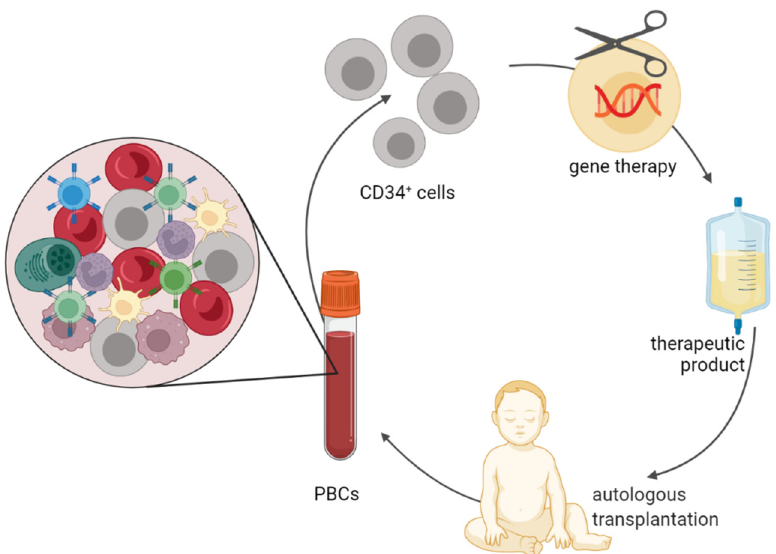
Figure 1. Overview of autologous HSC transplantation and corrective strategies for inborn errors of immunity using gene therapy. Created with BioRender.com.